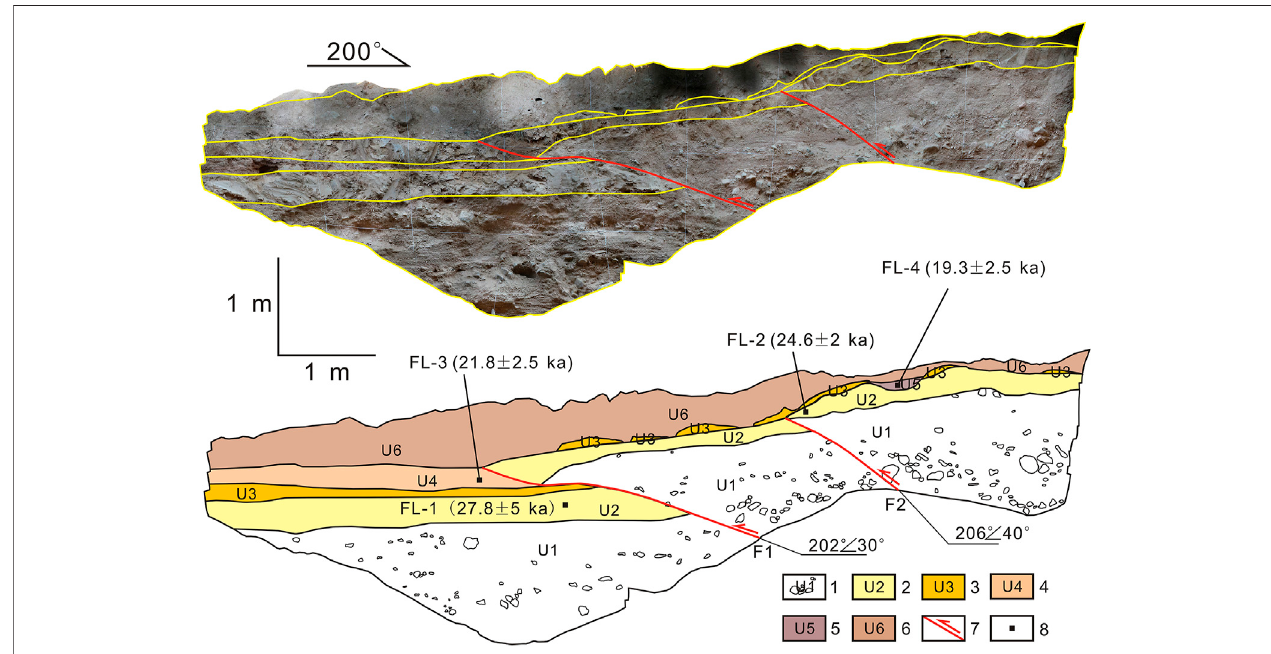
FIGURE 5 | The Dujiatuan village trench. This trench is excavated for dating the fl uvial fan D1 and two fault splays are discovered, designated as F1 and F2, respectively. Thefault F1 terminated upward at thebottom ofU6. Thefault F2iscapped byU3. Stratigraphic units: U1, coarse sand.U2, puresand. U3,mixtureofsand and tiny granules. U4, loess deposits. U5, channel deposits. U6, top soil. We identi fi ed two faulting events in the Late Pleistocene, designated as E1 and E2.